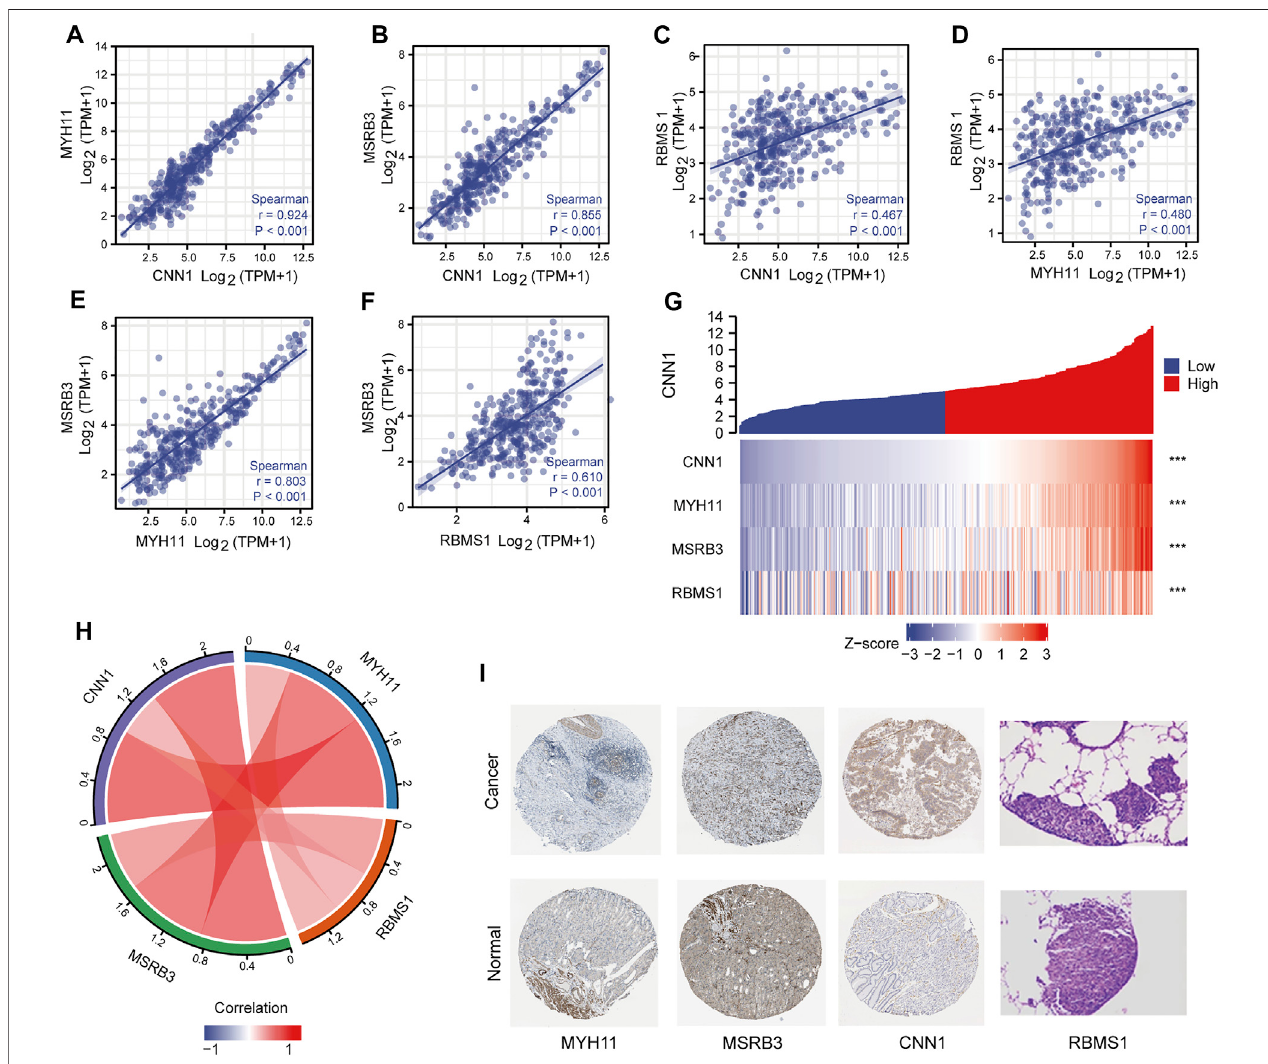
FIGURE5| Correlationanalysisbetweenfourprognosticgenes. (A – F) Scatterplotsshowingthecorrelation betweenfourprognosticgenes. (G,H) Chorddiagram and heatmap visualizing the correlation between four prognostic genes. (I) Immunohistochemical analysis of four prognostic genes.